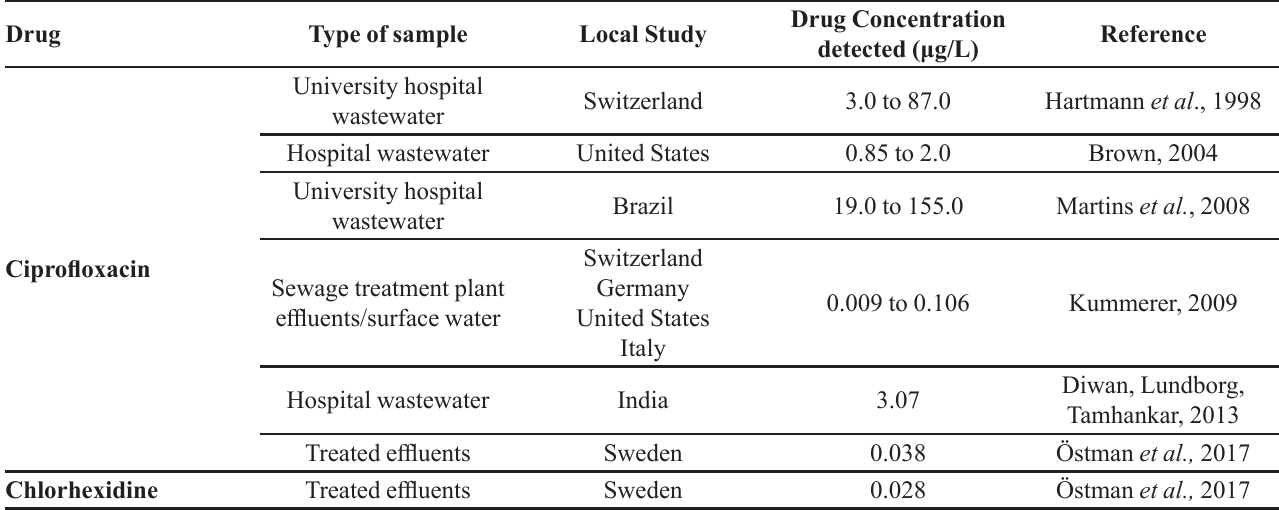
TABLE I - Detection of the antimicrobials ciprofloxacin and chlorhexidine in the aquatic environment Drug Type of